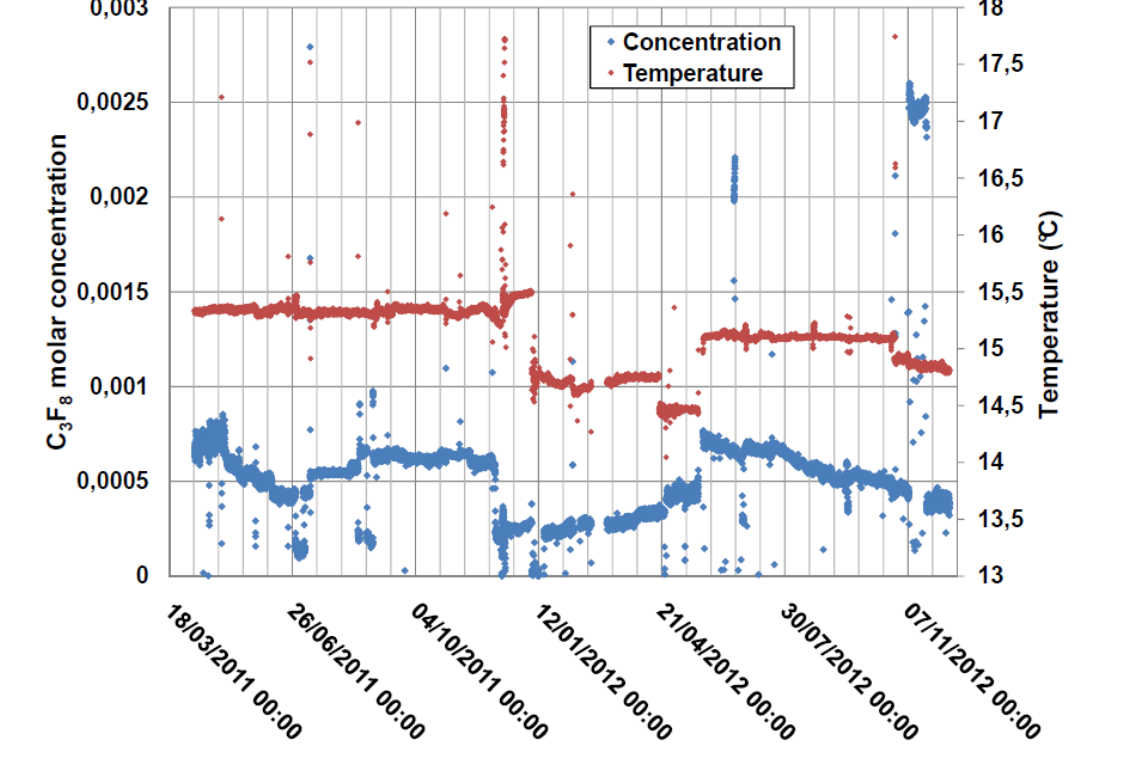
F leak contamination in 3 8